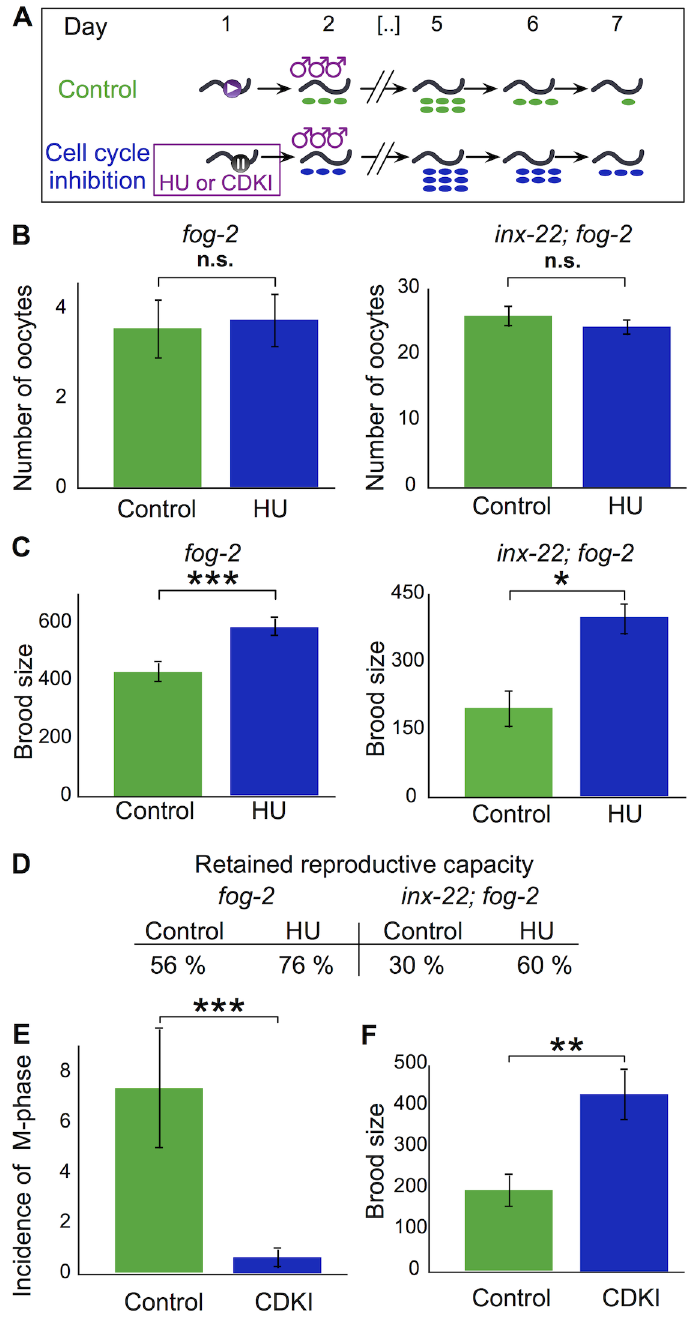
Fig 3. Stem cell cycling drives reproductive senescence. (A) Schematic of cell cycle inhibitor experiments. (B) Total number of oocytes produced by fog-2 or inx-22; fog-2 females during the HU treatment window. For statistical tests see S3A Table. (C) Brood size for fog-2 or inx-22; fog-2 females mated after the HU treatment window. For statistical tests see S3B Table. (D) Reproductive capacity retained by fog-2 or inx- 22; fog-2 females after HU or control treatment (computed by dividing numbers used in C by reproductive capacity at day 0). (E) Incidence of cells in M-phase following 24 h treatment with CDK inhibitor Roscovitine or control treatment with DMSO only. For statistical tests see S3D Table. (F) Brood size for fog-2 females mated after the Roscovitine treatment window. For statistical tests see S3E Table. Error bars represent 83% confidence intervals; asterisks indicate significance of Wilcoxon rank sum test